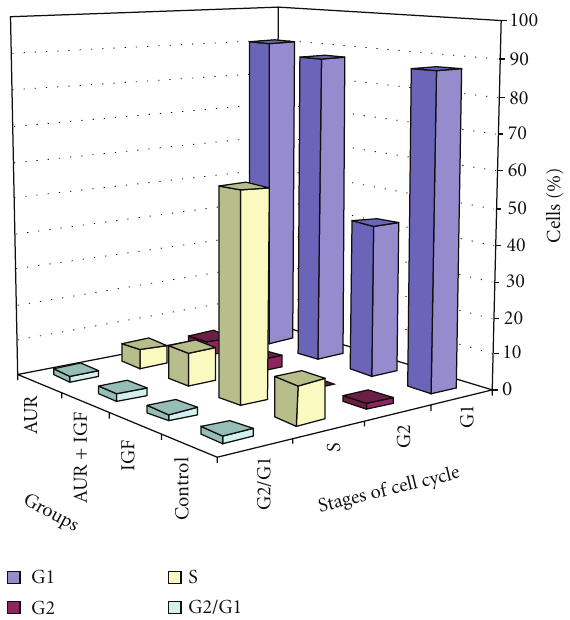
Figure 2: Cell cycle analysis of MCF-7 cells in the presence of IGF-1 at 24 h. MCF-7 cells were serum starved for 24h. At 22 h after serum starvation the cells were treated with 10 µ M auraptene in 0.01% DMSO. After 24h of serum starvation, the cells were treated with IGF-1 (10ng/mL). After 24h of IGF-1 treatment, the cells were harvested and processed for cell cycle analysis by flow